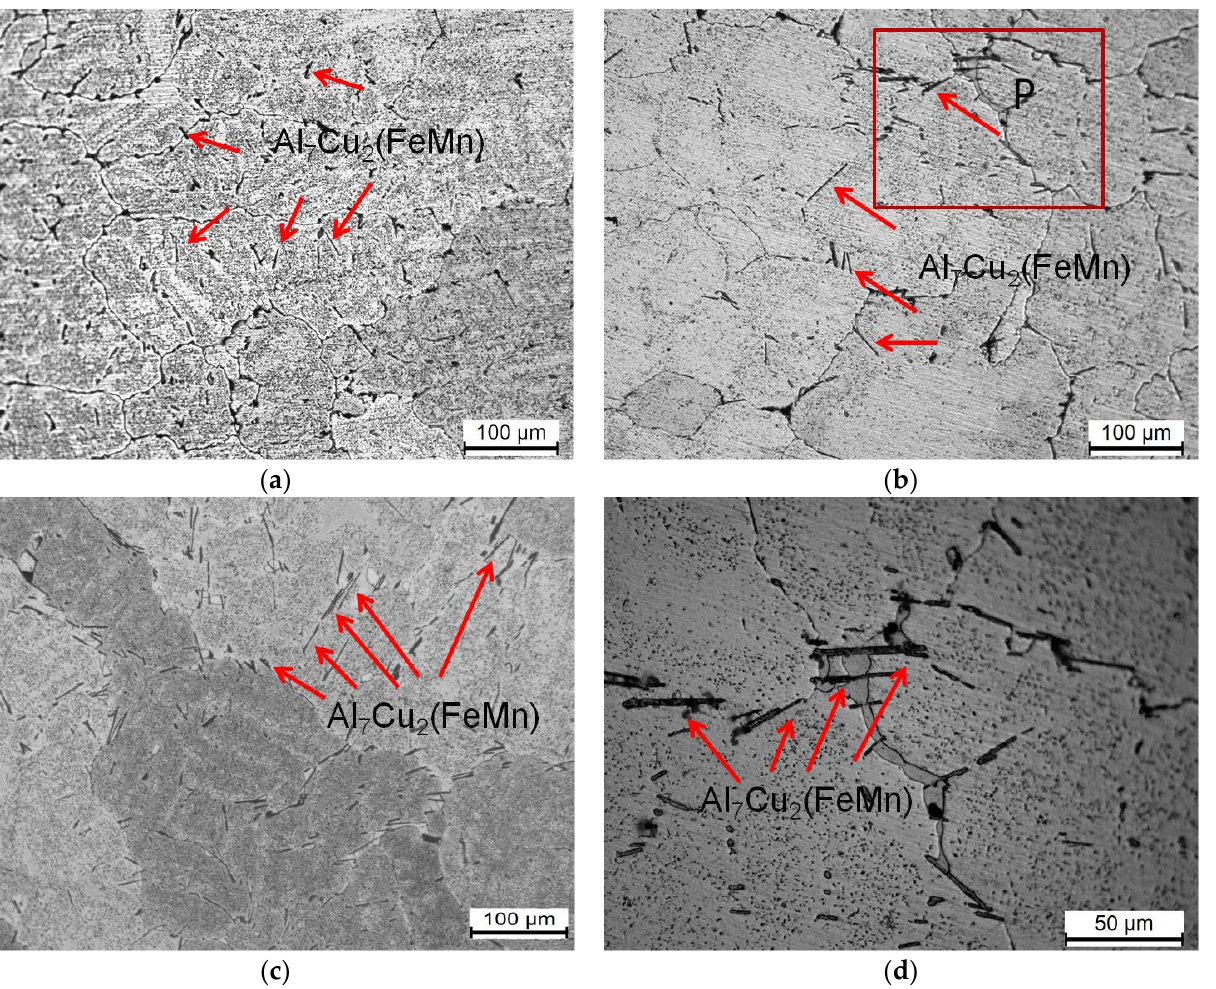
Figure 4. Microstructures of homogenized alloys with Fe contents: ( a ) 0.10 wt.%; ( b ) 0.15 wt.%; ( c ) 0.20 wt.%; and ( d ) high-magnification at location P.